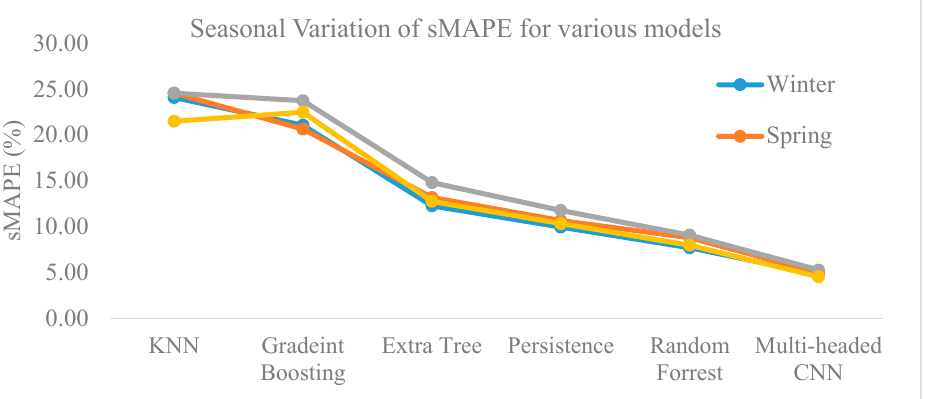
Figure 9. Seasonal variation of sMAPE for forecasting wind speed.